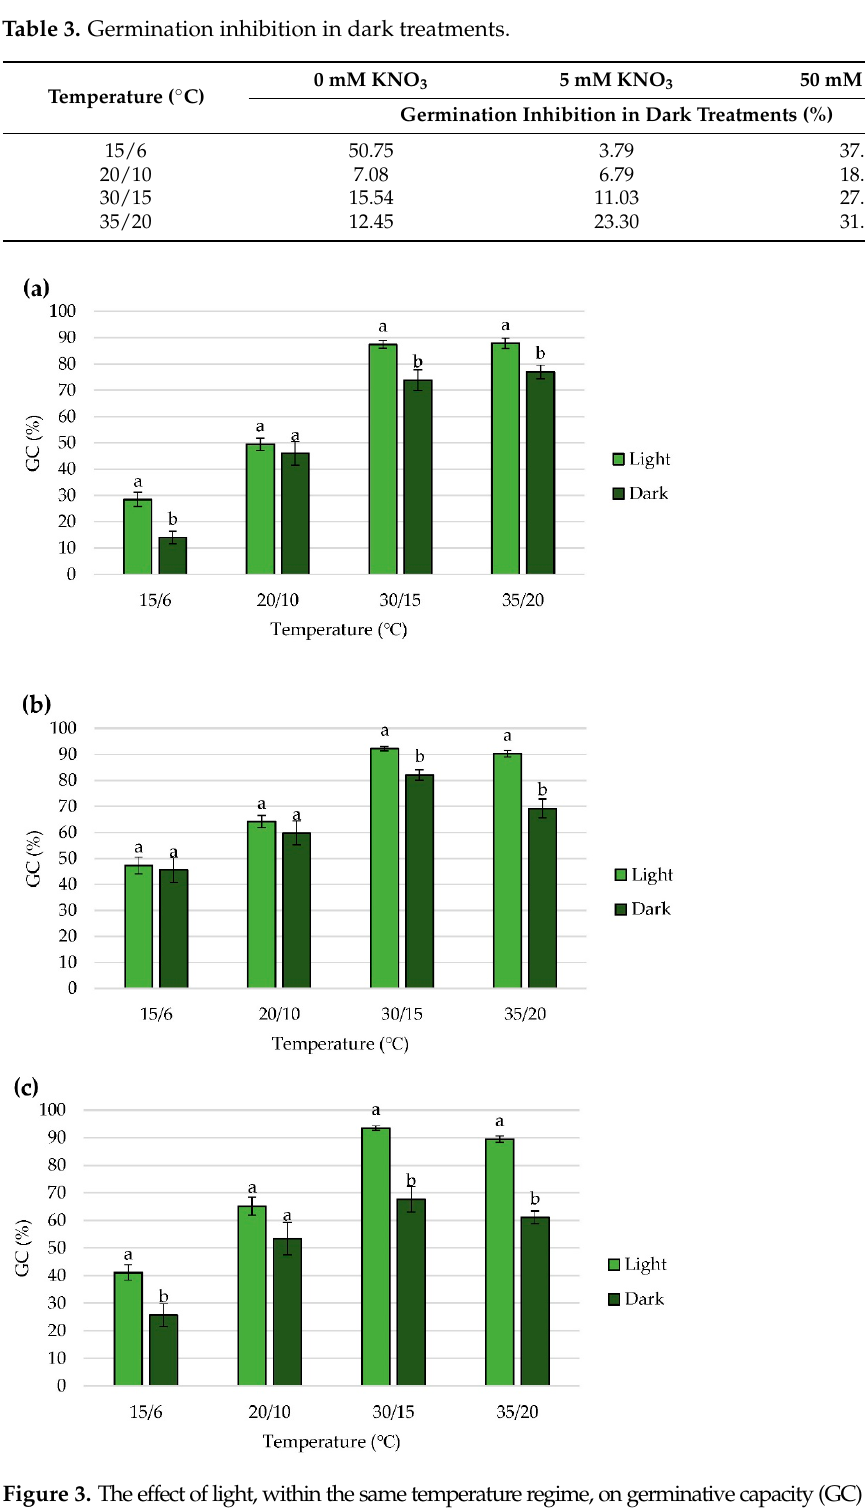
Figure 3. The effect of light, within the same temperature regime, on germinative capacity (GC) in treatments with ( a ) 0 mM KNO 3 ; ( b ) 5 mM KNO 3 ; ( c ) 50 mM KNO 3 . Each value represents the mean ± SE for three replicates. Mean values within the same temperature treatment with different letters differ significantly, p < 0.05.